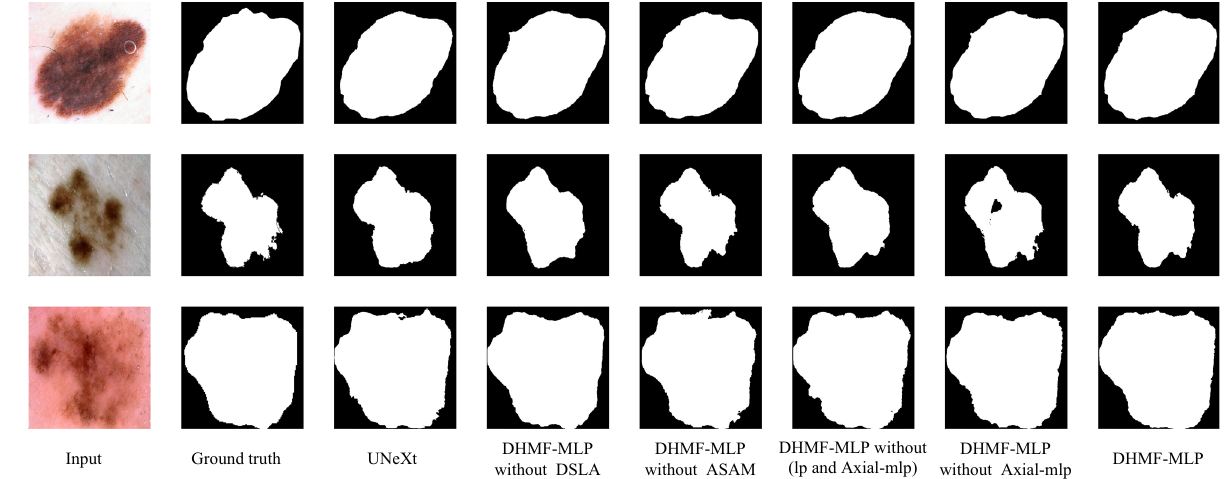
Figure 9. Ablation segmentation results of HMSF block on the ISIC 2018 dataset. From left to right: input, ground truth, UNeXt 22 , DHMF-MLP without DSLA, DHMF-MLP without ASAM, DHMF-MLP without (lp and Axial-mlp 21 ), DHMF-MLP without Axial-mlp 21 , DHMF-MLP(Ours). (created by ‘Microsoft Office Visio